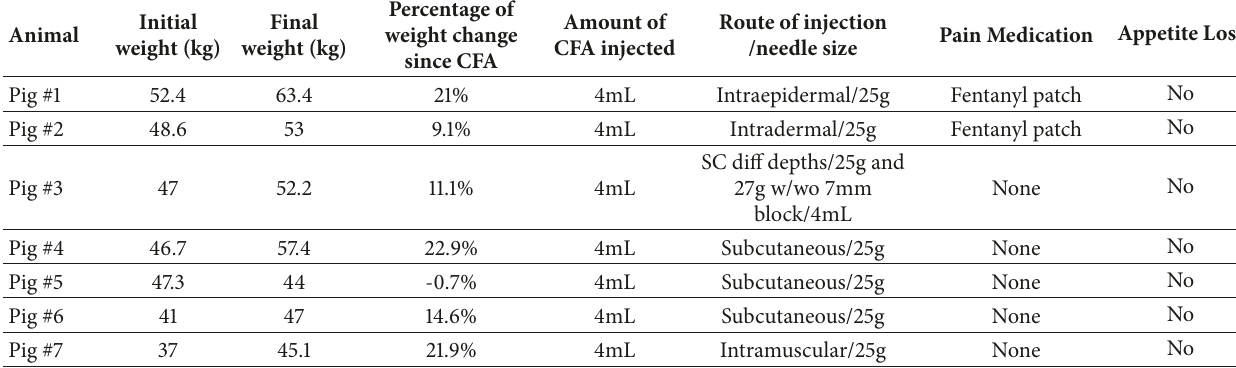
Table 1: Table describing the characteristics and demographics of the animals and interventions used.